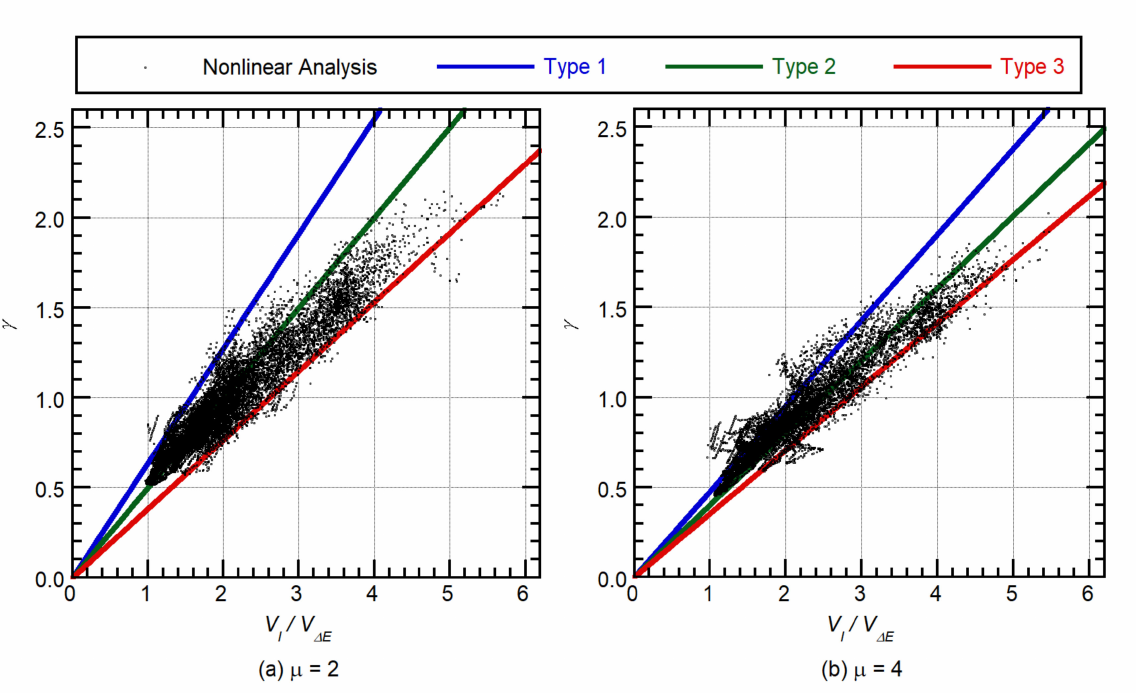
Figure 13. Comparison of relationship between V I / V ∆ E and γ obtained from nonlinear analysis results and equations considering three types of modelled hysteretic dissipated energy in a half